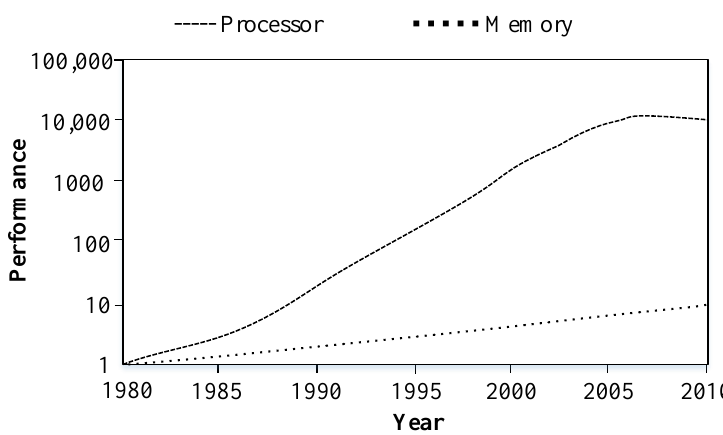
Figure 3. Processor–Memory performance gap over time exemplifying the memory wall problem